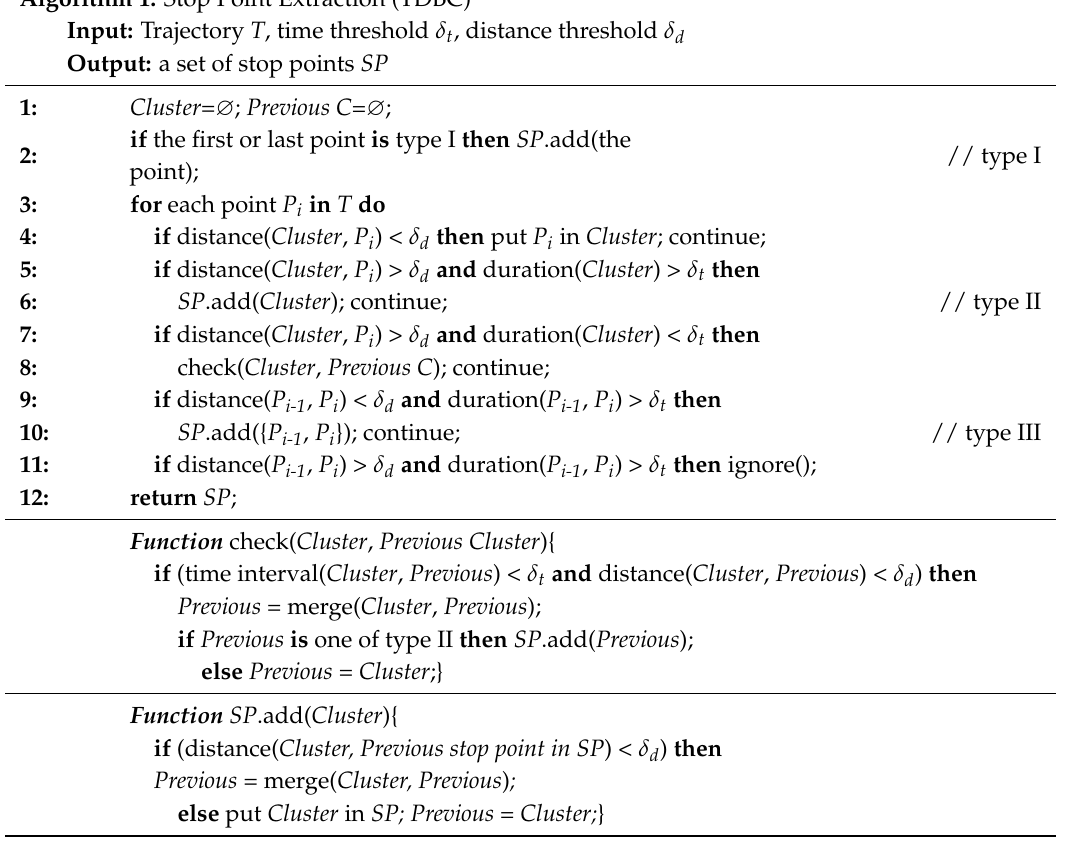
Algorithm 1. Stop Point Extraction